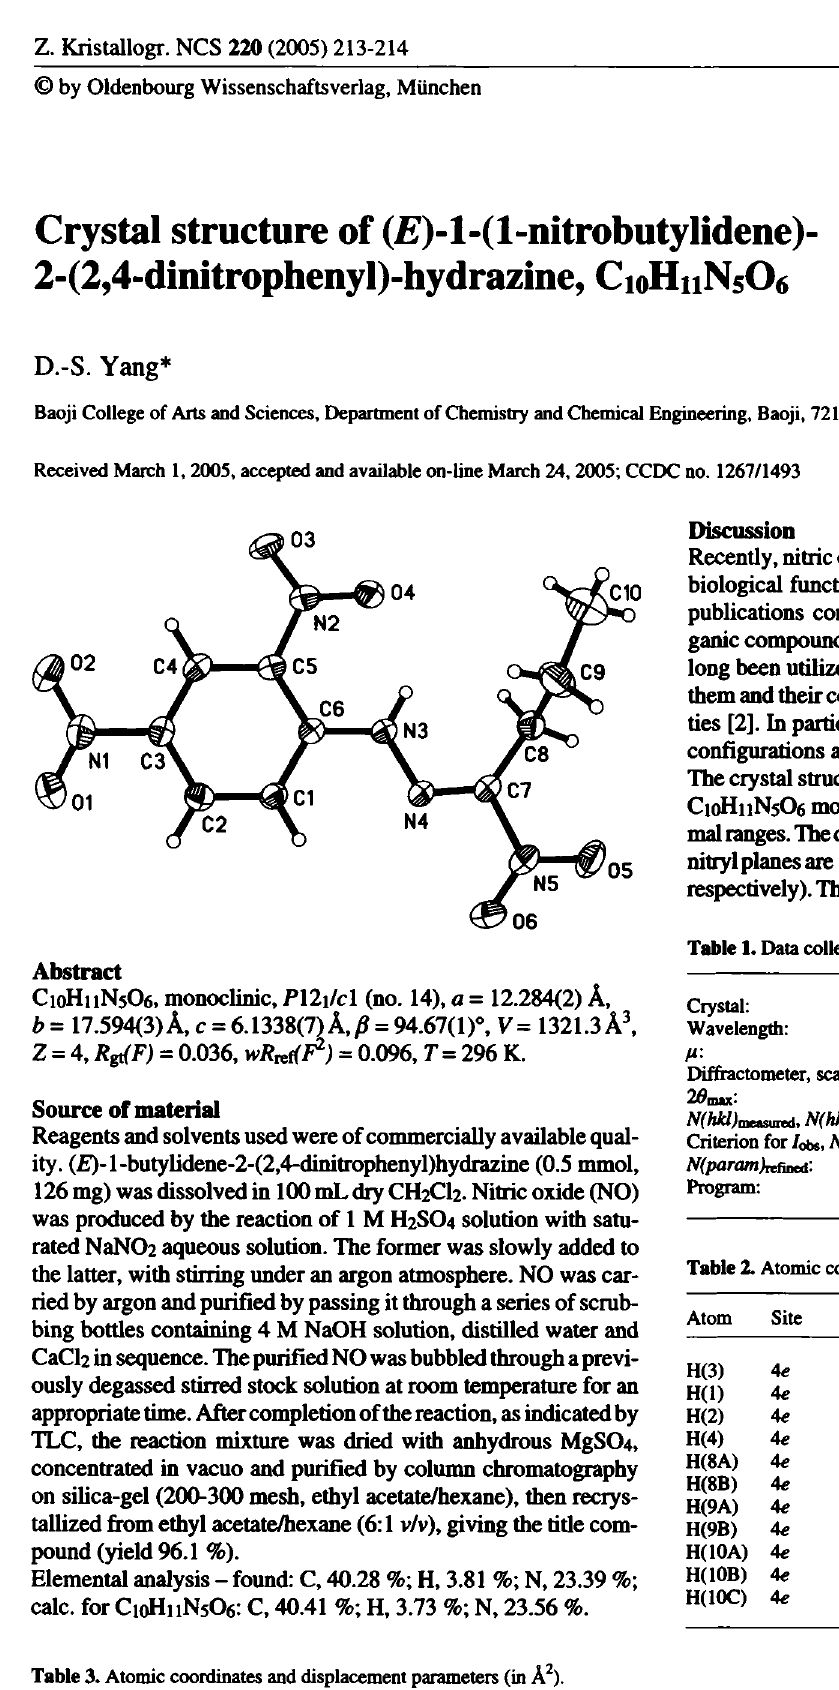
Table 3. Atomic coordinates and displacement parameters (in A 2 ).